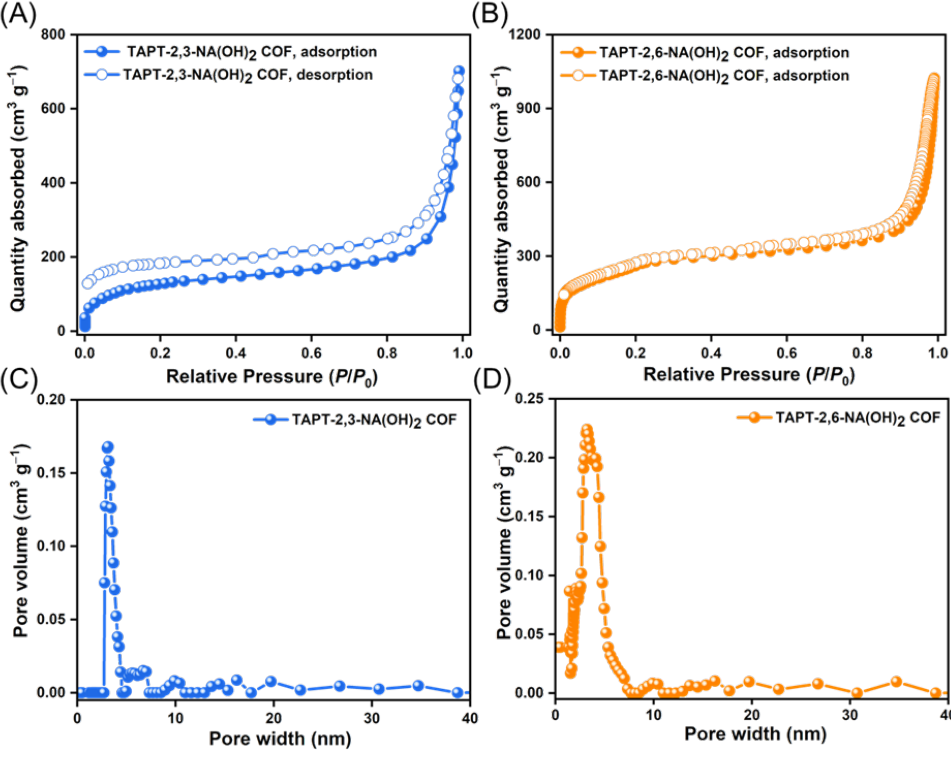
Figure 3. ( A , B ) N2 sorption isotherms recorded at 77 K of ( A ) TAPT-2,3-NA(OH) 2 and ( B ) TAPT-2,6-NA(OH) 2 COFs. ( C , D ) Pore size distributions of ( C ) TAPT-2,3-NA(OH) 2 and ( D ) TAPT-2,6-NA(OH) 2 COFs.